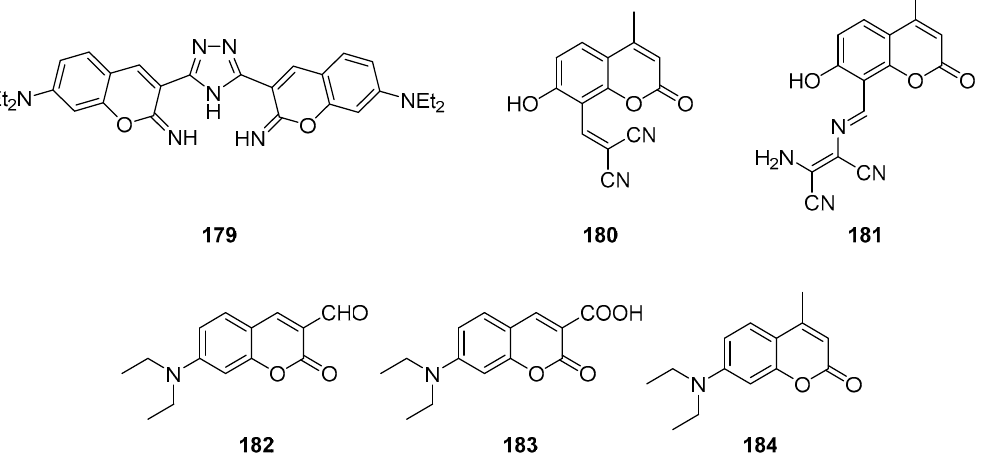
Figure 59. Coumarin florescent probes for hypochlorite ion detection.